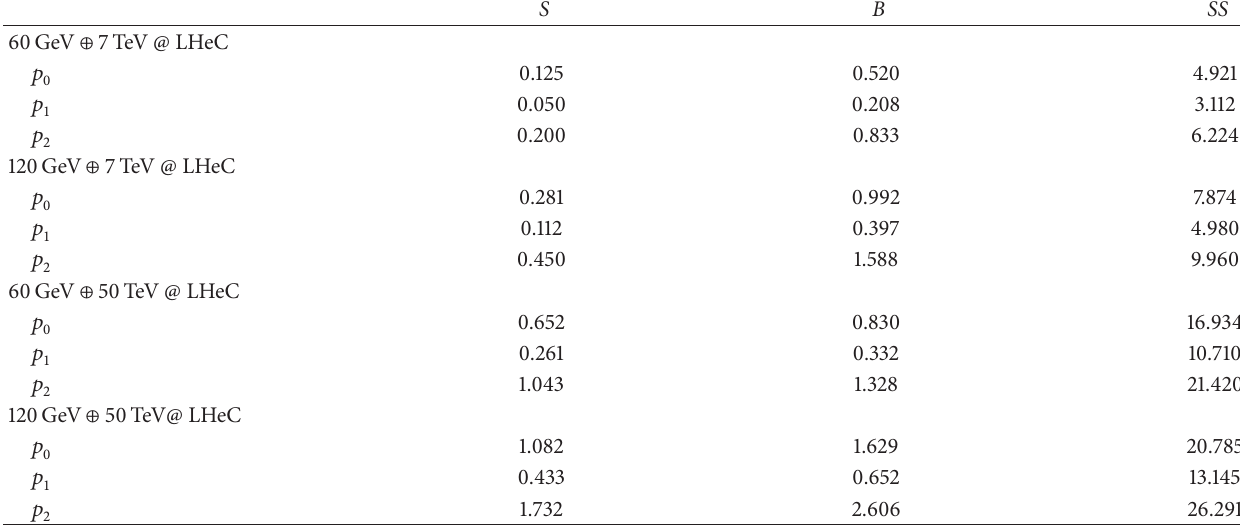
Table 3: The same as Table 2 but for MVA-based method. We select 𝑒 -beam polarization as 𝑝 0 = 0, 𝑝 1 = 0.6, and 𝑝 2 = −0.6